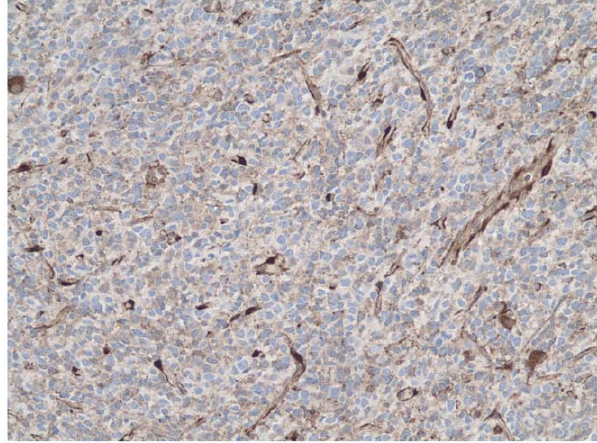
Figure 1. Immunohistochemical analysis, example of a patient with PTEN